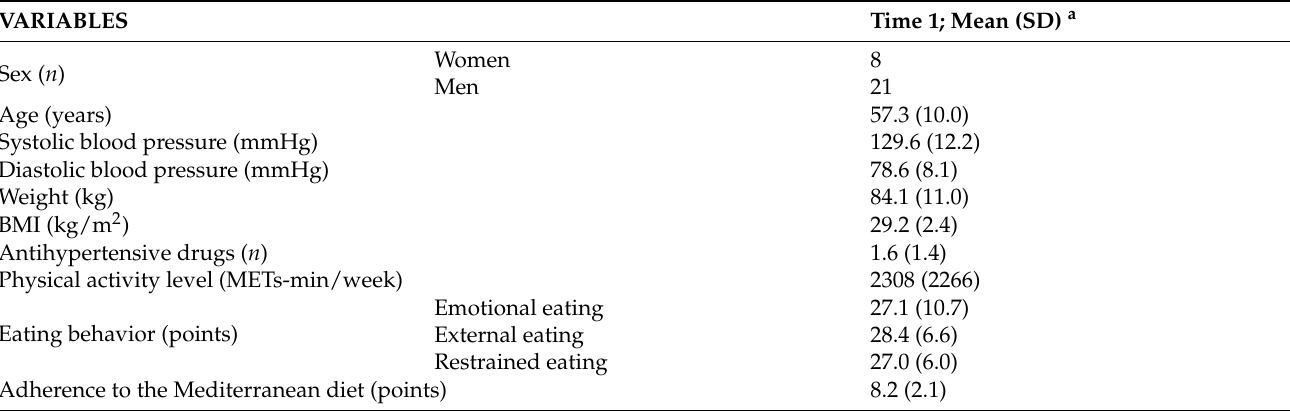
Table 1. Participant